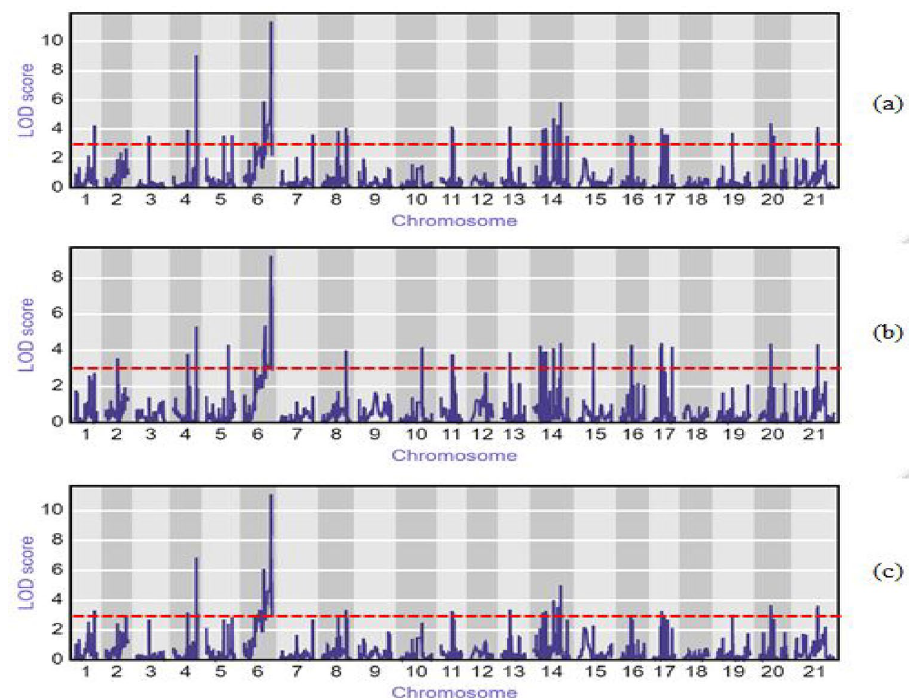
Figure 3. Significant QTL peaks in Y1 ( a ), Y2 ( b ) and CY ( c ) using CIM method in DH lines of ITMI population.